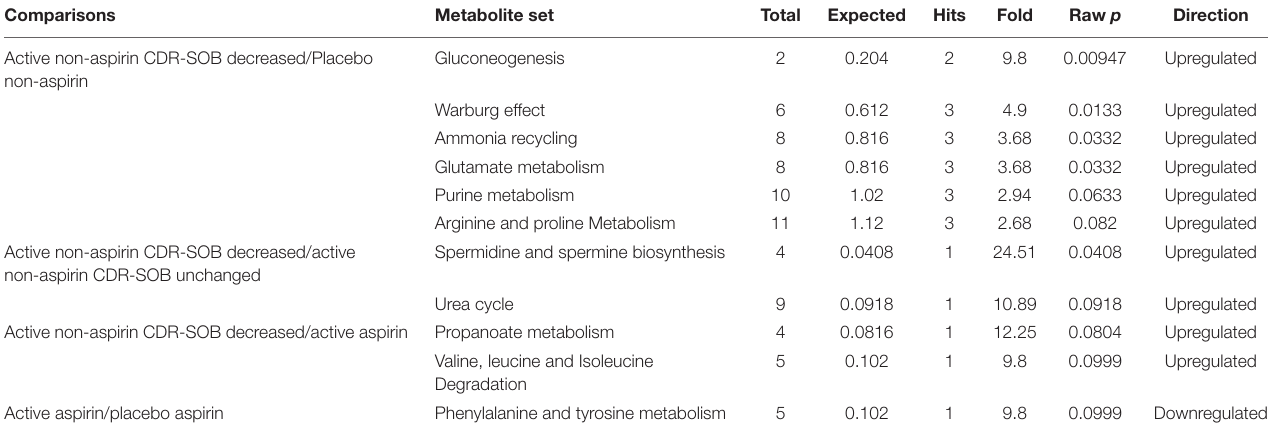
TABLE 2 | Summary of top altered pathways.